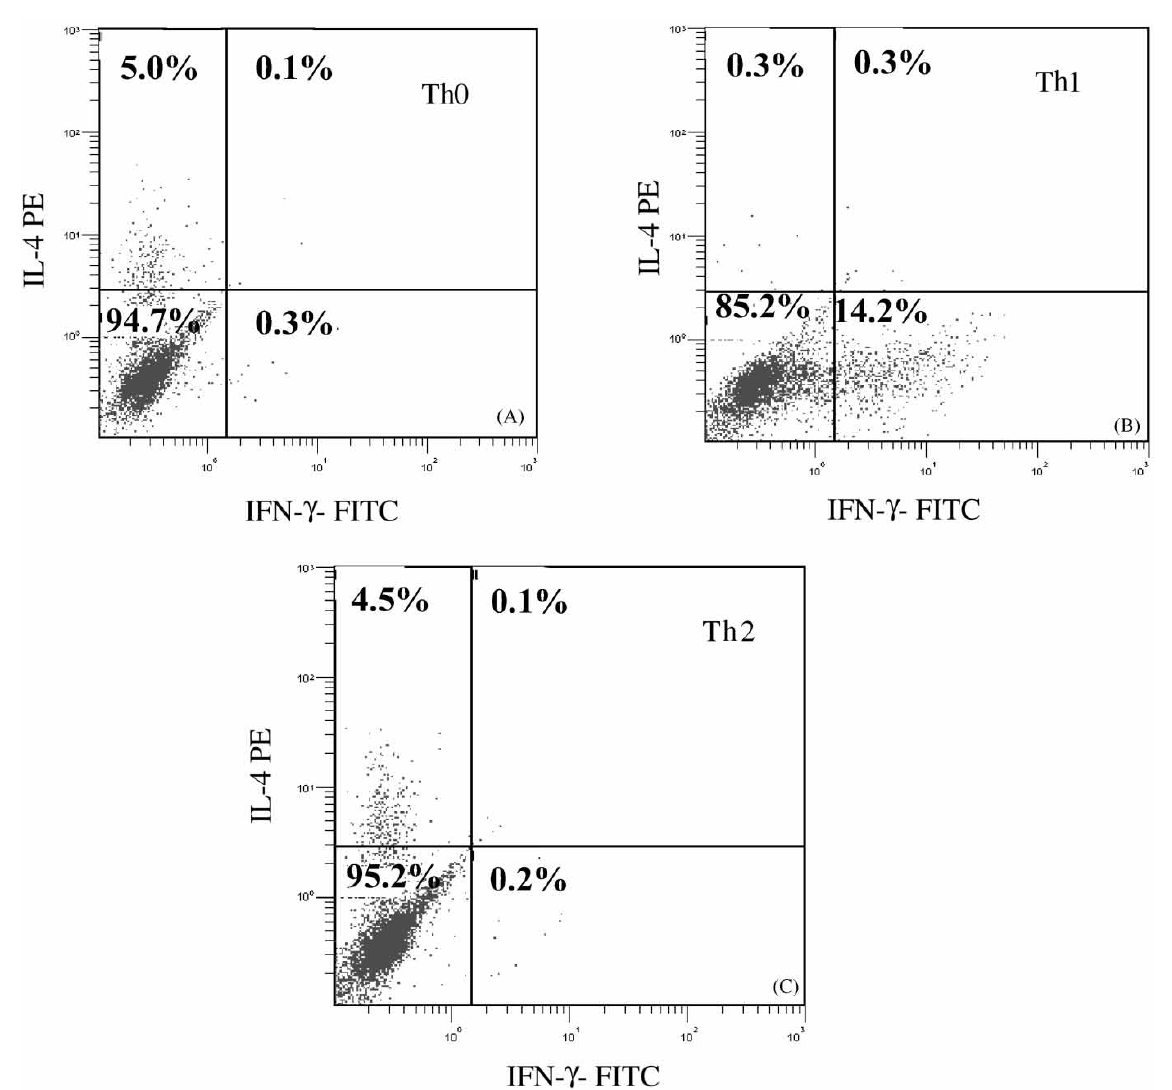
FIG. 6. IL-4 and IFN- g dual staining of T h 0, T h 1 and T h 2 polarised CD4 (cid:2) T cells from repeatedly PBS-treated mice. T h 0 stimulation indicates that 5.0% of the cells were IL-4-positive, while IFN- g -positive cells were of very low number (0.3%). Under T h 1 stimulatory conditions, however, this IL-4-positive population disappears. A total of 14.2% of T h cells under these conditions are IFN- g producers. T h 2 polarisation, however sees a return to low number of IFN- g -positive cells, with IL-4- producing cells detected at